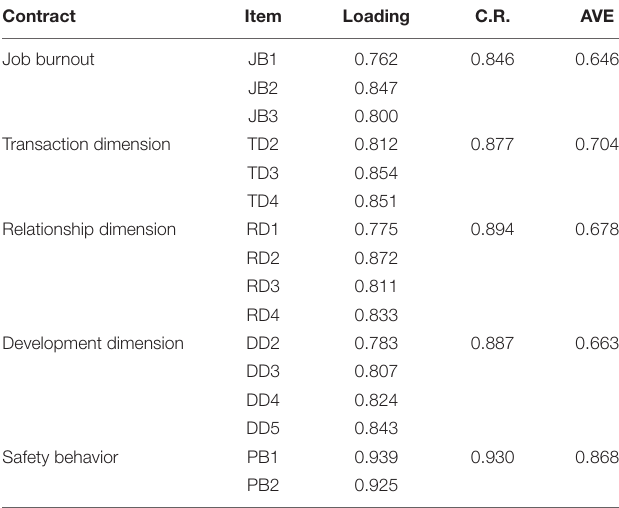
TABLE 4 | SEM analysis ( N =